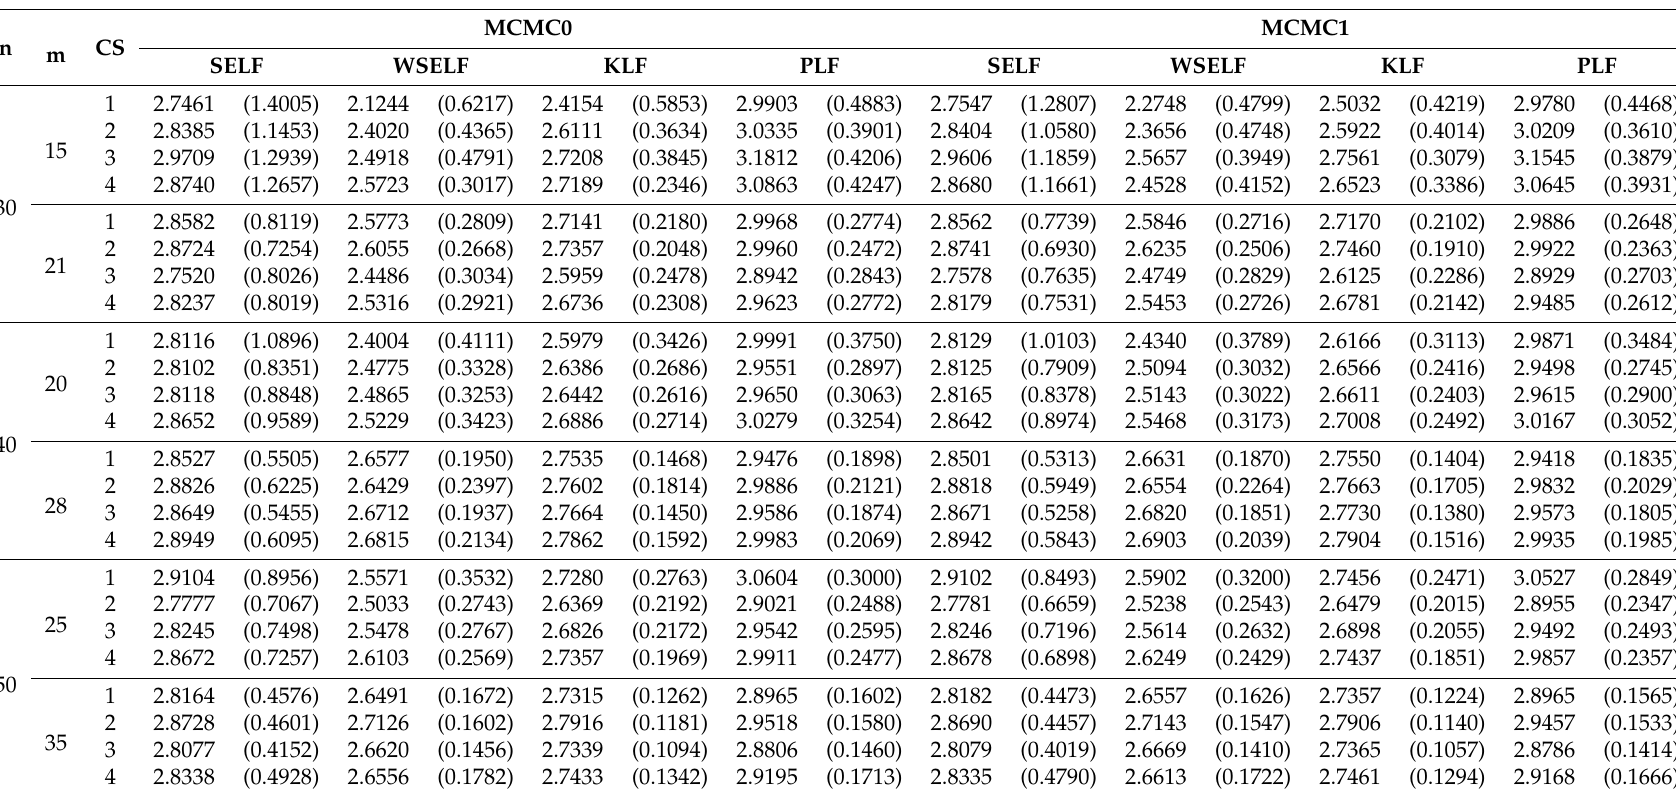
Table 4. Bayesian estimates and corresponding PRs (in brackets) of entropy for Pareto distribution with α = 0.8 and β = 0.8 under different censoring schemes